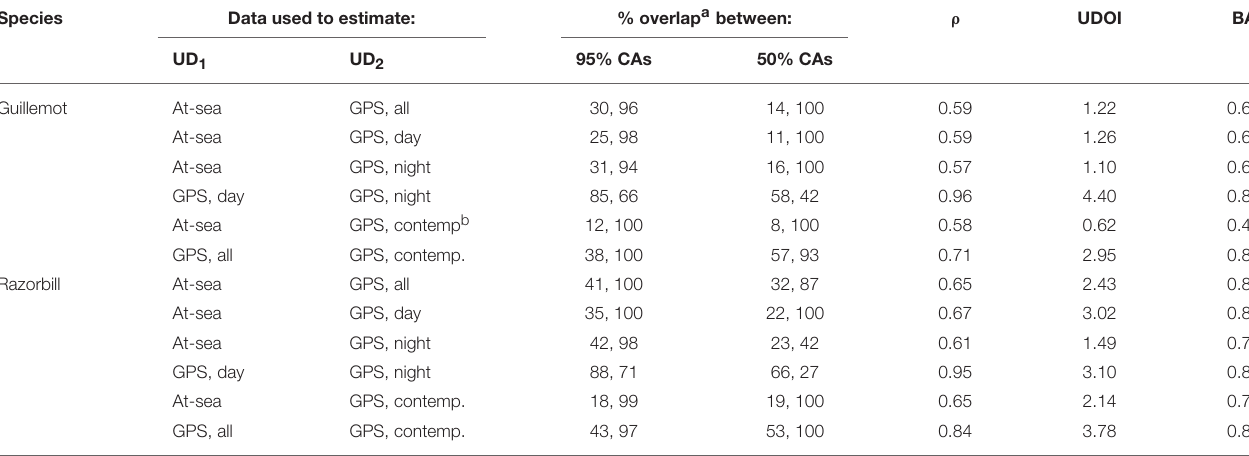
TABLE 2 | Overlap and similarity between seabird utilization distributions (UDs) estimated using data from at-sea surveys and GPS tracking. Species Data used to estimate: % overlap a between: